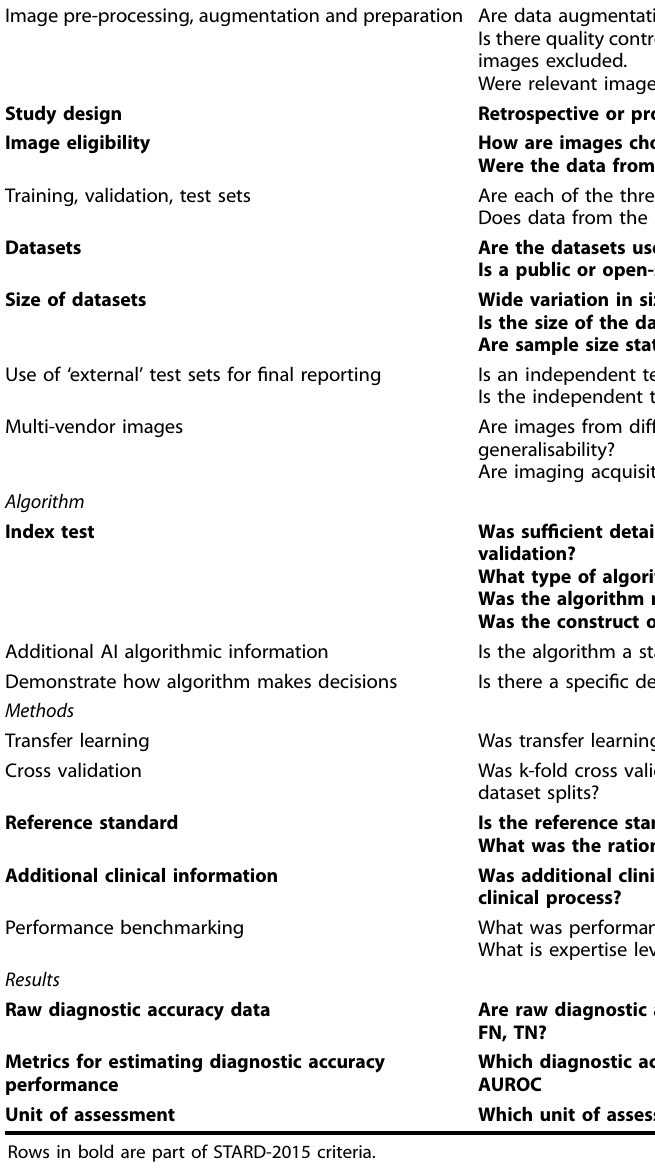
Table 5. Variation in DL imaging studies. Data Image pre-processing, augmentation and preparation Are data augmentation techniques such as cropping, padding and fl ipping used? Study